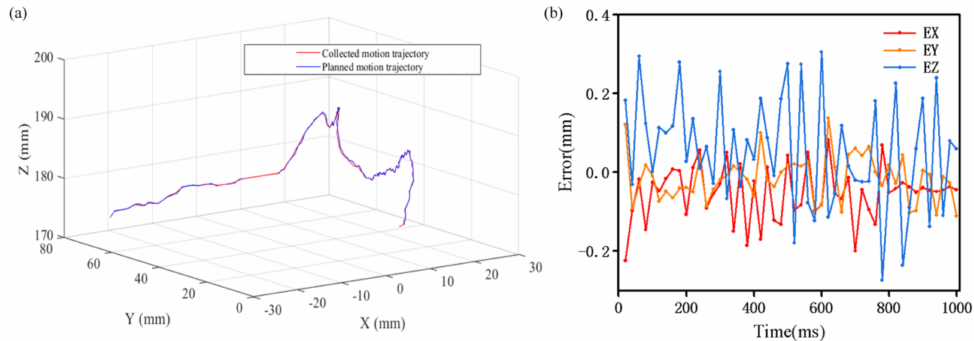
Figure 9. Analysis of the planned and collected trajectories: ( a ) trajectory of the collected movement and the planned movement of the instrument; ( b ) deviation between the actual position and the given position.